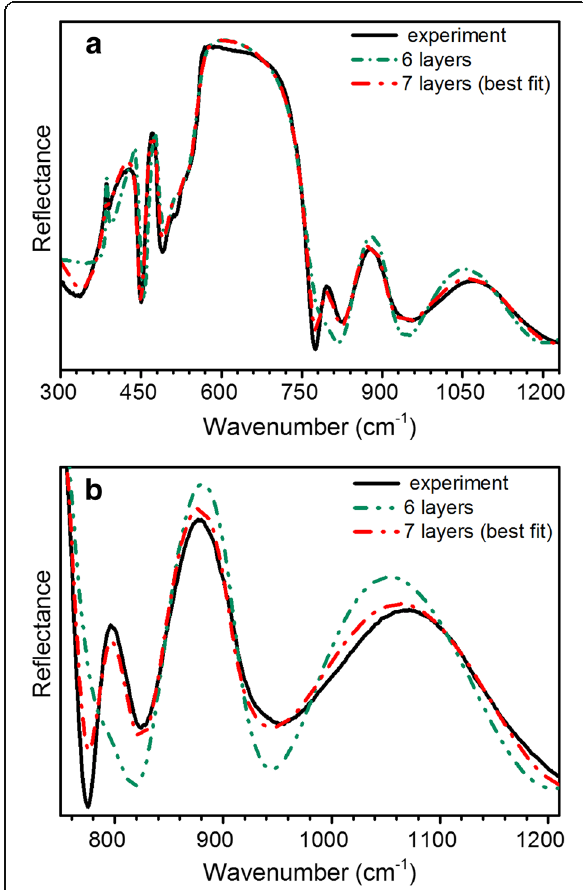
Fig. 4 Simulations of the IR reflectance spectra with different number of layers. The experimental spectrum of the investigated n + /n 0 /n + -GaN structure is shown by solid line . a Reststrahlen region. b The enlarged spectra in the range above 750 cm − 1